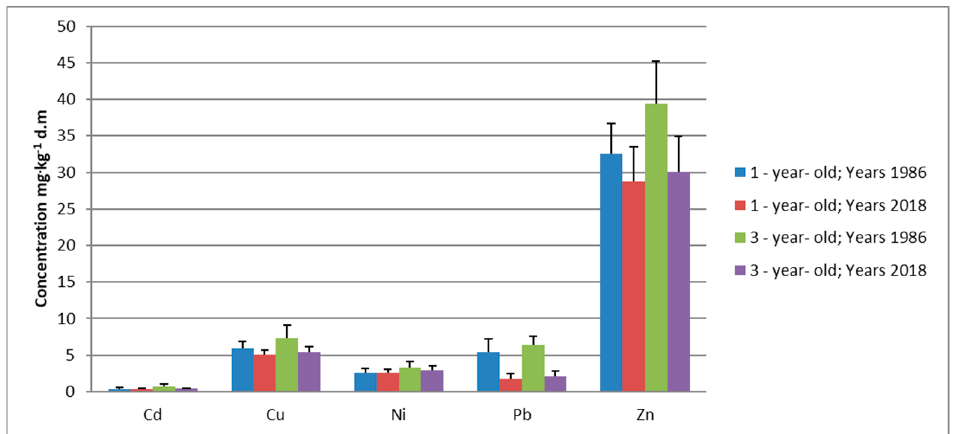
Figure 5. The contents of selected micronutrients in 1-year-old and 3-year-old silver fir needles in milligrams per kilogram of dry matter (mg kg − 1 d.m) (mean values ± SD; n = 10).